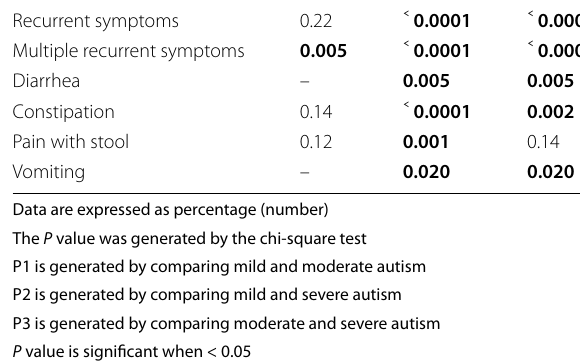
Table 5 The percentage of each of the chronic symptoms in the whole population of the